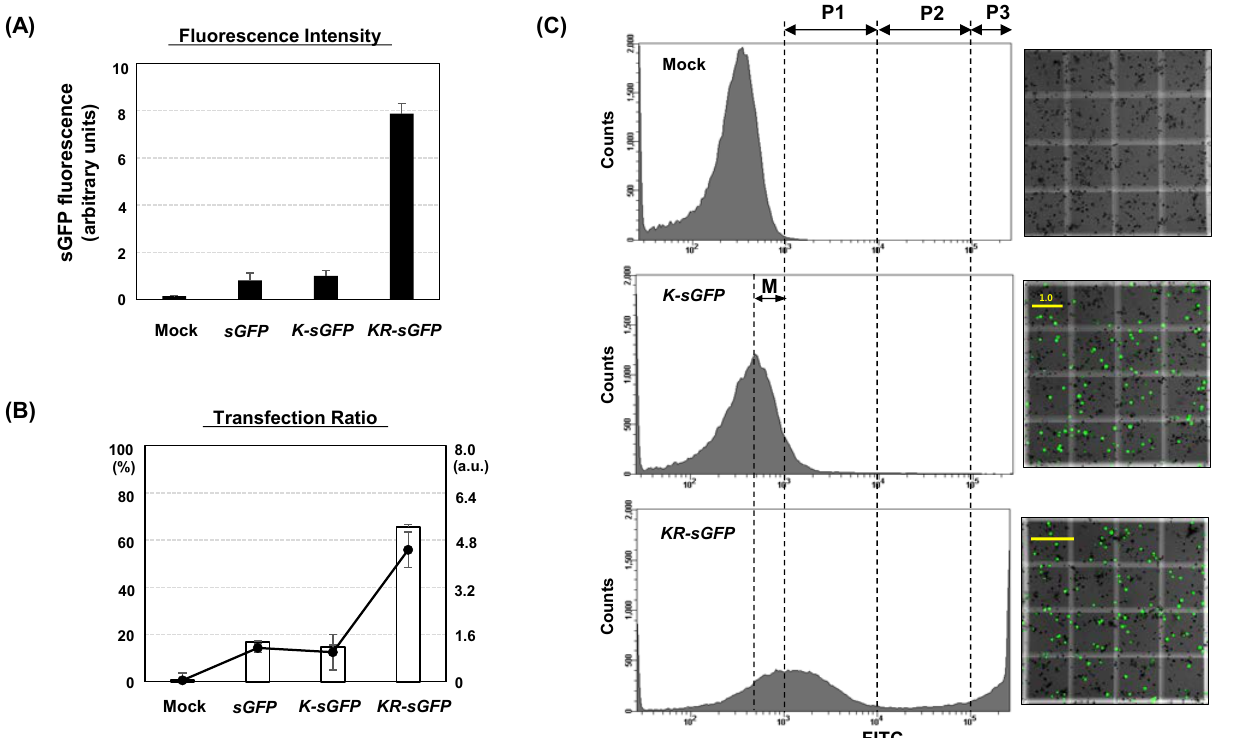
Figure 2. Comparative analysis of FCA using rice protoplasts among sGFP , K-sGFP and KR-sGFP constructs. Rice protoplasts were transfected with 5 μg plasmids of sGFP , K-sGFP, and KR-sGFP constructs. The FCAs were performed using single live cells gated by the side/forward scattering. ( A ) The fluorescence intensities were analyzed using the fluorescein isothiocyanate (FITC-A) channel of the flow cytometer and normalized by the average fluorescence intensity of the K-sGFP construct. The results are presented in arbitrary units; ( B ) The ratio of protoplasts with a fluorescence intensity exceeding the threshold value (10 3 ) to the gated protoplasts was calculated on FCA. The left axis shows the percentage of the transfected protoplasts expressing sGFP and the right axis shows their arbitrary results. The error bars show the SEM (standard error of the mean) for the data acquired from three independent transfections. Mock samples were prepared by PEG-transfection with no plasmid DNA and ( C ) Flow cytometry histograms ( left panels) and the images of hemocytometer measurements ( right panels). The fluorescence intensity on FITC was partitioned into P1 (10 3 –10 4 ), P2 (10 4 –10 5 ), and P3 (>10 5 ) subpopulations, and M means “the missing population”. For a hemocytometer analysis, 10 μL of the transformed protoplasts was mounted on a hemocytometer, and were photographed using the DIC and FITC-A channels of a confocal microscope (200× magnification). The merged images of one square (1 mm 2 ) on the hemocytometer were shown. The sGFP-expressing cells were identified as the green fluorescent signals, and the yellow scale bars on the images show the mean intensity ratio (for 10 6 pixels) of the green fluorescence, analyzed by a Histogram tool. Taken together, these results suggest that the sGFP targeting into chloroplasts using rRTp plays an important role in improving the fluorescence intensity of FCA to increase the population with higher fluorescence than the threshold value, as well as to increase its average fluorescence intensity